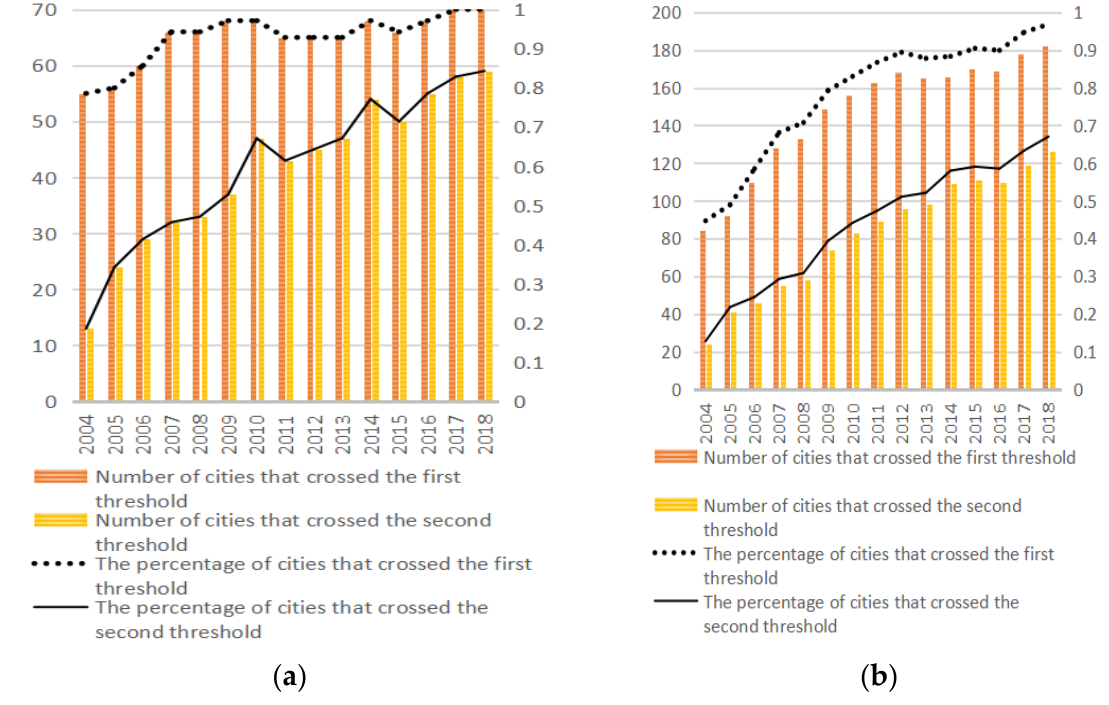
Figure 6. Comparison of threshold crossing between innovative and non-innovative cities (taking the environmental regulation as threshold): ( a ) Innovative city, ( b ) Non-innovative city.